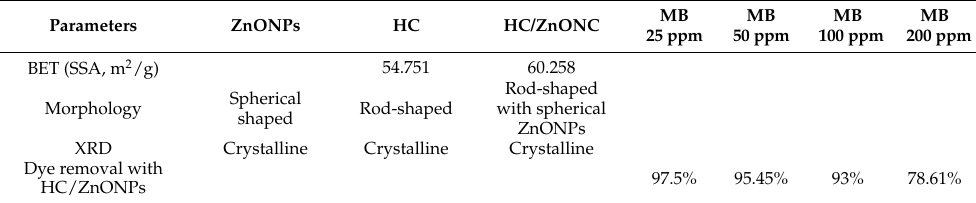
Figure 14. Percent removal of MB dye for different concentrations using HC/ZnONC. Table 4. Summarized result of the materials and dye